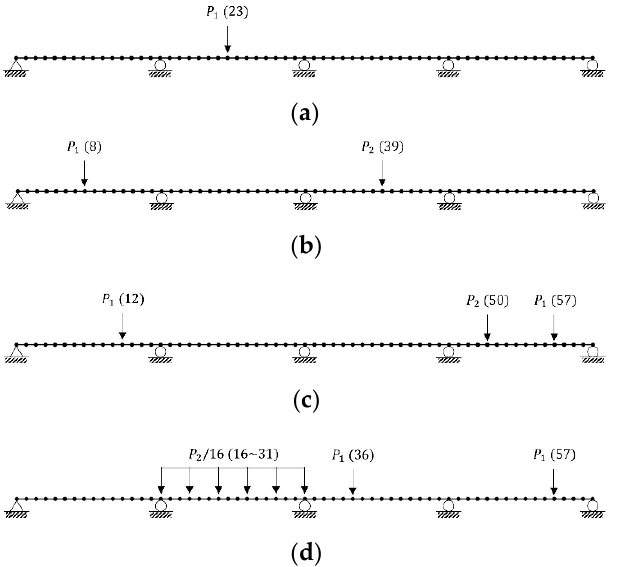
Figure 4. FEM model for validation (truss): ( a ) node number, ( b ) element number.